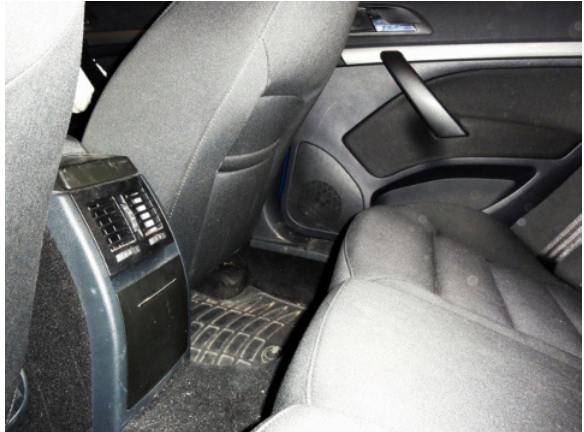
Fig. 4. Air-conditioning mouth outlet for rear row seats in Škoda Octavia II